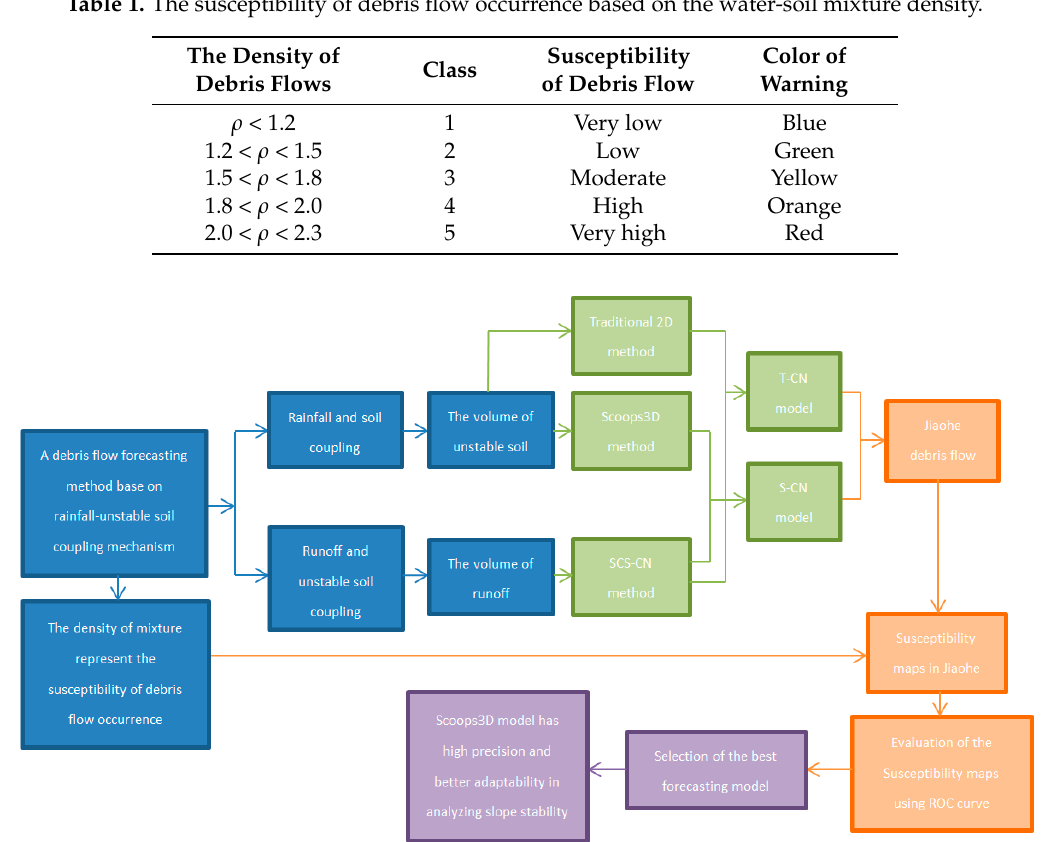
Figure 1. The flowchart of the debris flow prediction method based on the rainfall-unstable soil coupling mechanism (R-USCM). (SCS-CN: soil conservation service-curve number) Table 1. The susceptibility of debris flow occurrence based on the water-soil mixture density. The Density of Susceptibility of Class Color of Warning Debris Flows Debris Flow